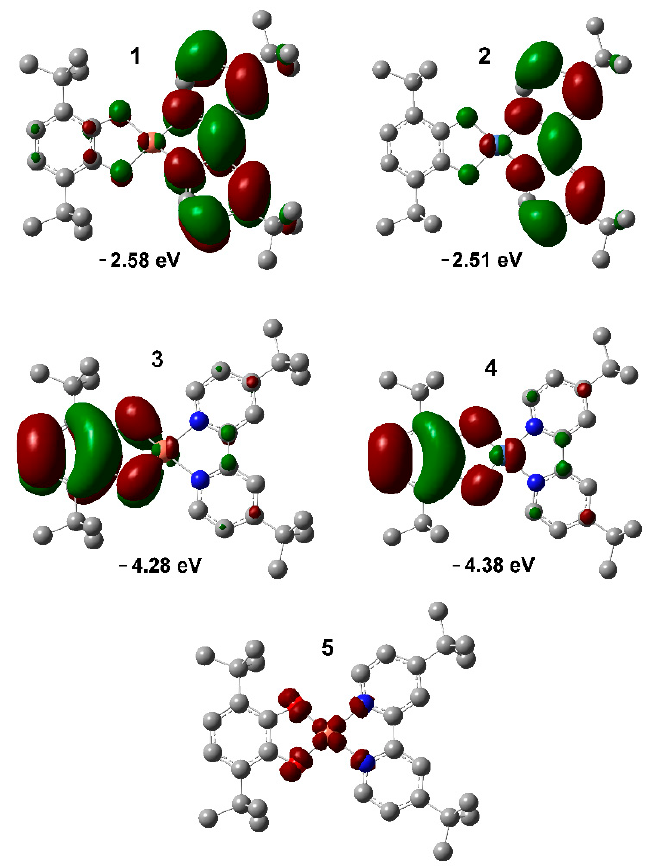
Figure 9. Views of calculated frontier orbitals for complexes 1 (1, 3; isovalue = 0.02), and 2 (2, 4; isovalue = 0.02) and the spin density distribution for complex 1 (5; isovalue = 0.005).